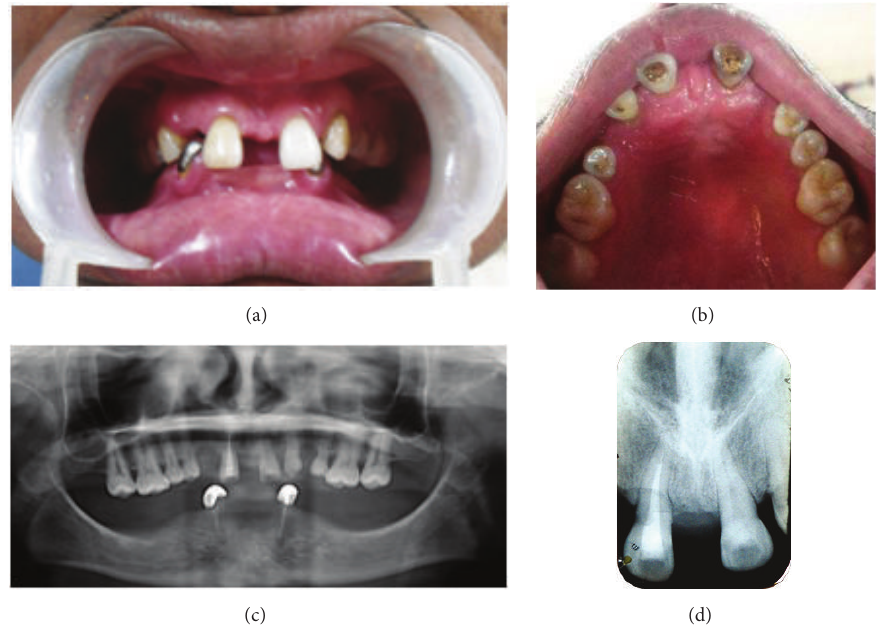
Figure 3: (a) Intraoral photograph of Sibling 3. (b) Intraoral photograph of maxillary arch of Sibling 3. (c) OPG of Sibling 3. (d) IOPA of Sibling 3 showing incisor with dens